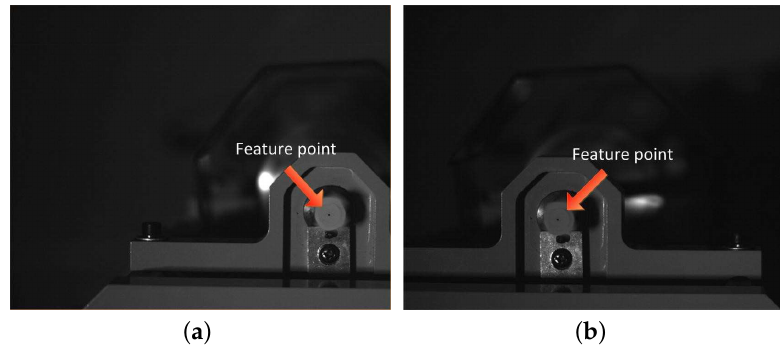
Figure 6. The raw images captured by binocular stereo video system: ( a ) left camera; and ( b ) right camera.